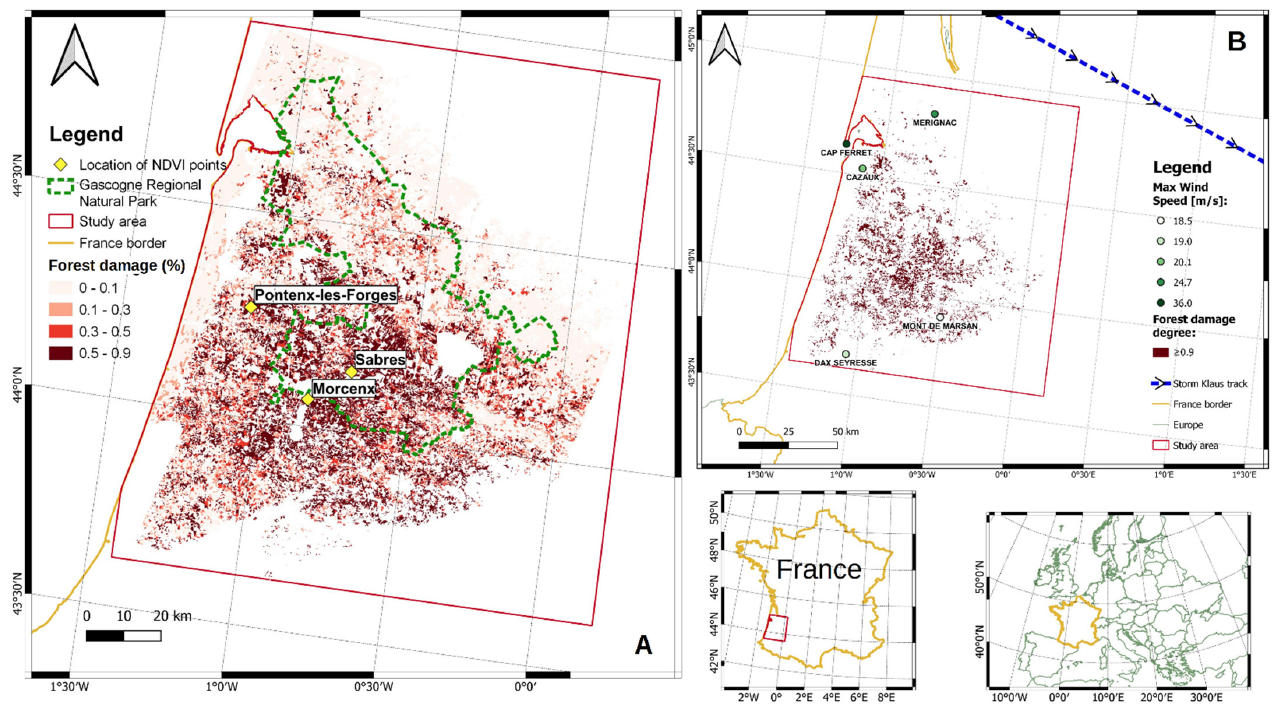
Figure 1. Study area with damage indicated according to the FORWIND database Forzieri et al. [30]. Map ( A ): the degree of forest damage (%) detected after windstorm Klaus in SW France. Yellow squares indicate places for which NDVI and LAI timeseries were constructed and showed in Figure 2. Map ( B ): the maximum wind speed for selected meteorological stations showed against the highest class of forest damage degree ( ≥ 0.9), and the windstorm Klaus trajectory (dashed blue line). According to the Koppen-Geier climate classification [31], the climate of the area under study is temperate and oceanic, with hot summers and no dry season (Cfb). The mean annual temperature in Cazaux is +13.4 ◦ C (+6.6 ◦ C in January, +20.6 ◦ C in July), while in Mont de Marsan the mean annual temperature is +13.2 ◦ C (+5.7 ◦ C in January, +21.1 ◦ C